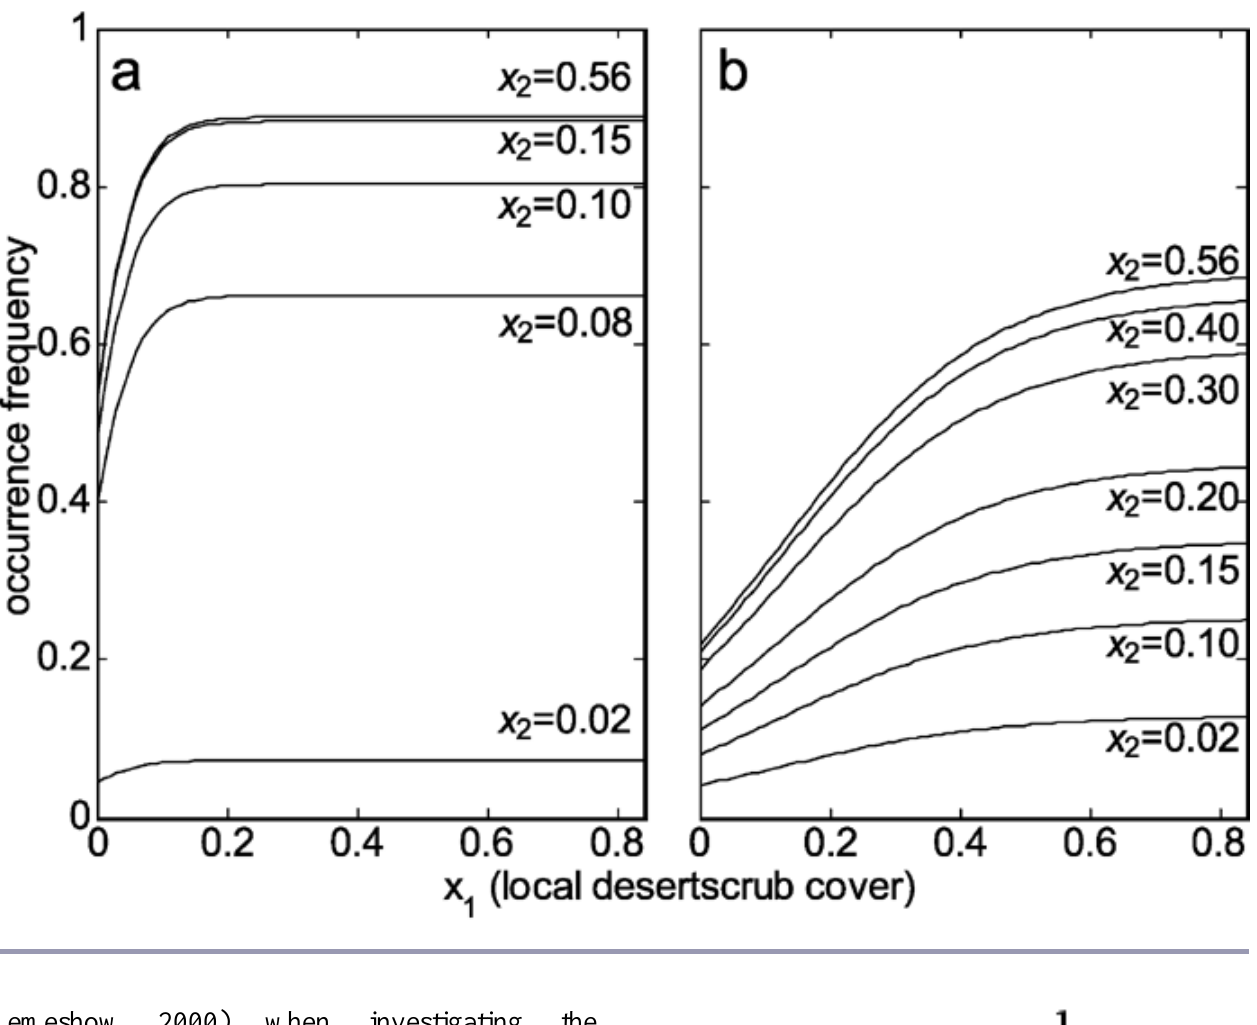
Fig. 4. Maximum likelihood fits of model M reveal differences among species in responses to CONSTRAINT habitat at different spatial scales. Shown are (a) Gambel’s Quail (GAQU) and (b) Ash-throated Flycatcher (ATFL), two species for which M was the best model. Each line shows the fitted response to CONSTRAINT local habitat, i.e., x , the proportion desertscrub cover within 56 m, for a selected value of landscape habitat 1 and x , the proportion desertscrub cover within 1784 2